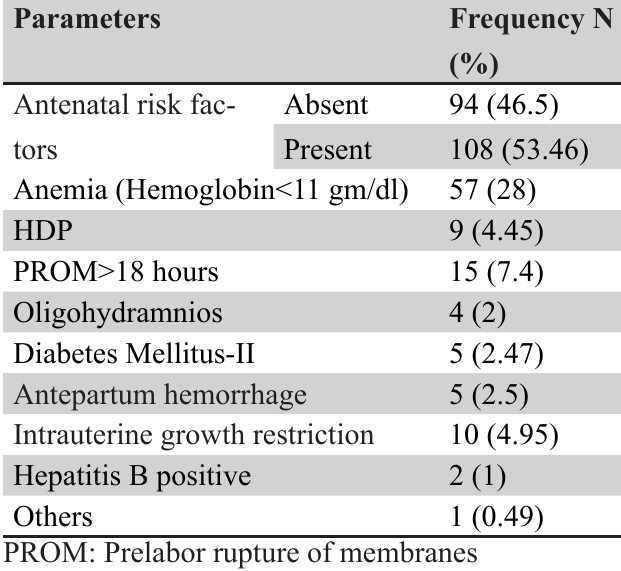
Table 2. Antenatal risk factors in cases of MSAF.